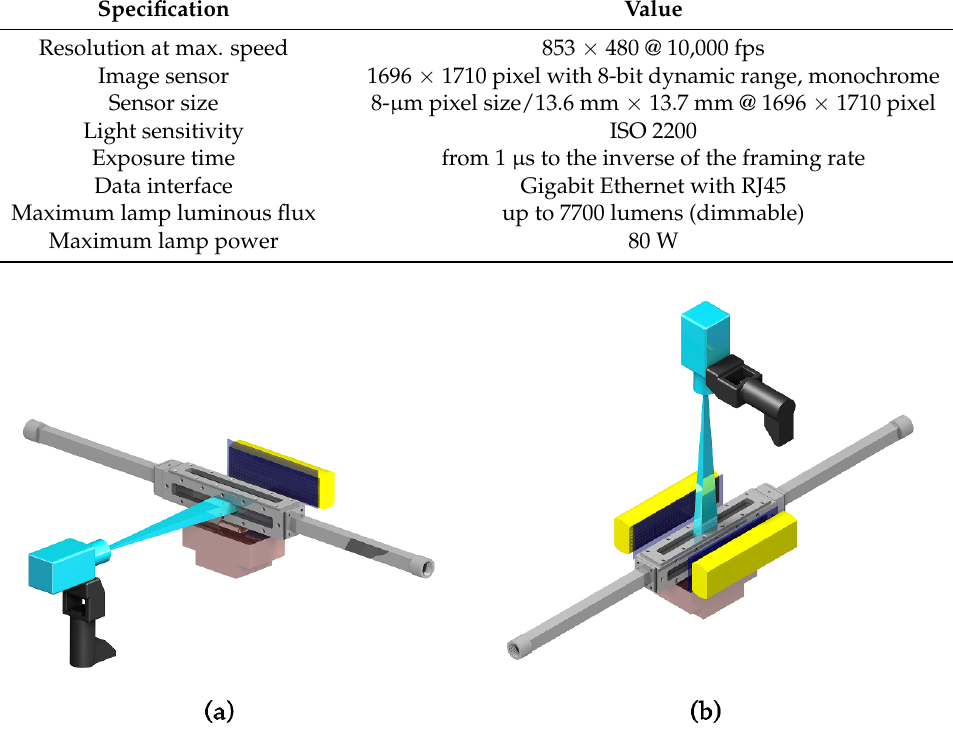
Table 1. Characteristics of the machine vision system.